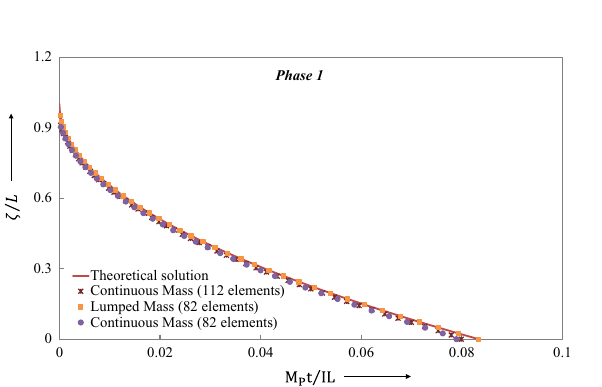
Figure 9. Final central displacement of the beam predicted by theoretical and LCP discretizations.